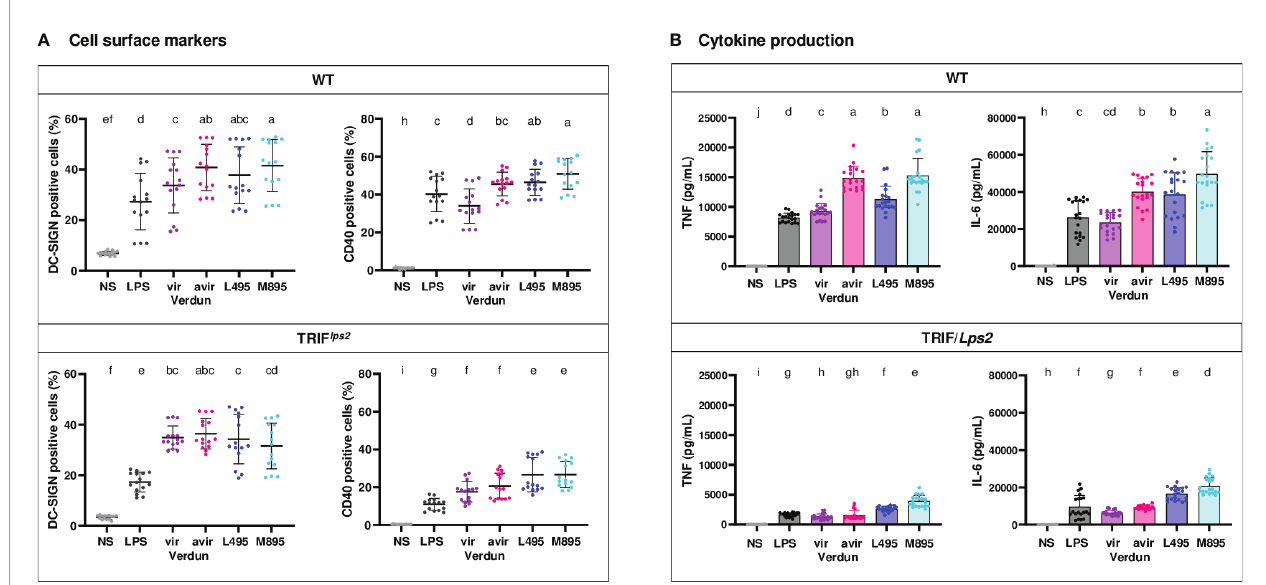
FIGURE 6 | Contribution of the TRIF adaptor in the difference of BM-DCs activation upon stimulation with virulent compared to avirulent pathogenic strains of leptospires. Day 8 WT and TRIF/ Lps2 BM-DCs from C57BL/6 mice were stimulated with virulent and avirulent leptospires from the Verdun (Verdun vir and Verdun avir) and Manilae L495 (L495 and M895) strains at a Multiplicity of Infection (MOI) of 50 bacteria per cell. E . coli LPS (1 µg/mL) was used as a positive control for DCs stimulation. After 24h, cells were immunostained for the analysis of the expression of DC-SIGN and CD40 by fl ow cytometry (A, dot plot). TNF and IL-6 concentrations were also quanti fi ed in cell supernatants by ELISA assays (B, histograms with dot plot). Data were compared to results with non- stimulated cells (NS). Each dot represents technical triplicates (A) or quadruplicates (B) from two independent experiments with n=5 mice. Mean ± SD is also represented. Statistics indicated with lower-case letters allow for comparing, for each marker and each cytokine, all conditions within WT (upper panel) and TRIF/ Lps2 (lower panel). Conditions that share the same lower-case letters are not signi fi cantly different (p > 0.05). In contrast, conditions that do not share same letter(s) are signi fi cantly